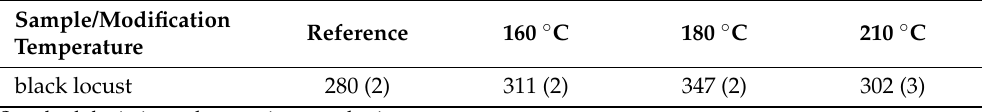
Table 6. Cellulose degree of